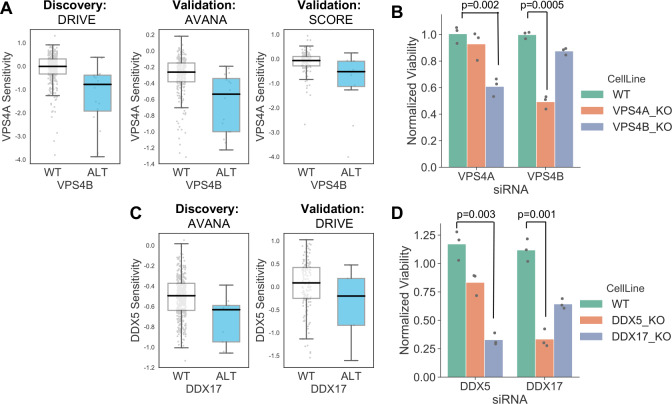
Robust synthetic lethalities associated with passenger gene loss.(A) Boxplots showing the association between VPS4B loss and VPS4A sensitivity in the discovery dataset (DRIVE) and two validation datasets (AVANA and SCORE). (B) Mean viability of HAP1 cells treated with siRNA smartpools targeting VPS4A or VPS4B. Individual data points are shown as black dots. Data are normalized within each cell line such that the mean viability of cells treated with a negative control (non-targeting scrambled siRNA) is equal to one and the mean viability treated with a positive control (siRNA smartpool targeting the broadly essential PLK1 gene) is equal to 0. P-values from two-sided heteroscedastic T-tests. (C) Boxplots showing the association between DDX17 loss and DDX5 sensitivity in the discovery dataset (AVANA) and the validation dataset (DRIVE). (D) Mean viability of HAP1 cells treated with siRNA smartpools targeting DDX5 or DDX17, normalization and statistics as per B.